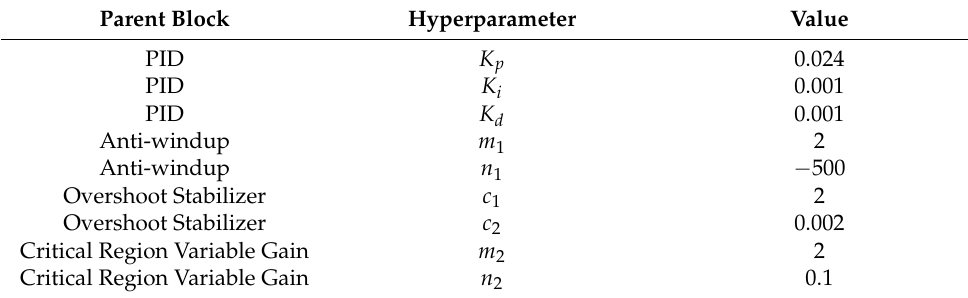
Table 1. NASS-controller-selected